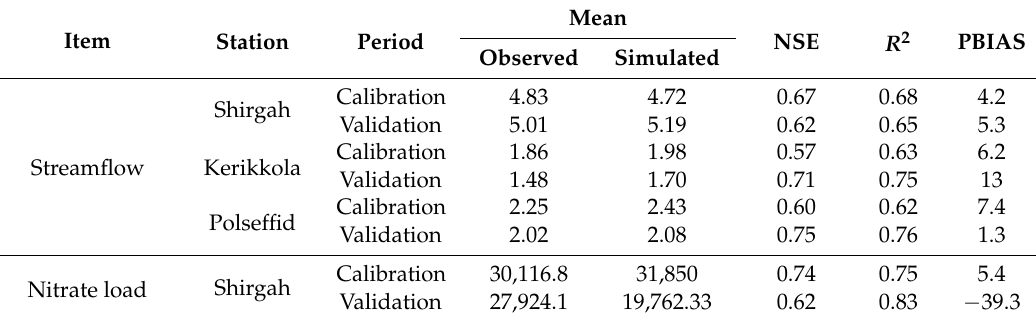
Table 8. Model statistical evaluation for monthly flow and nitrate load for